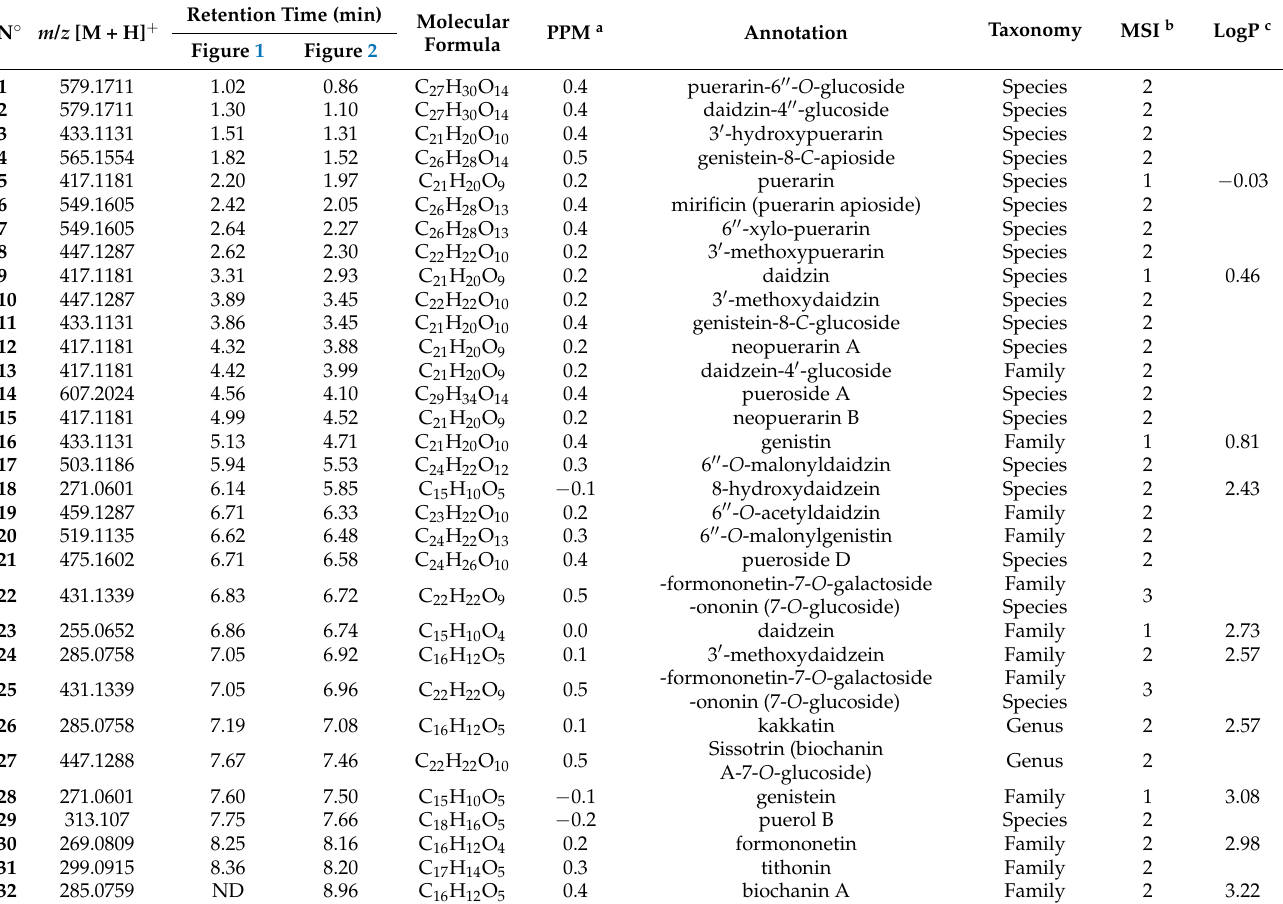
Table 1. Annotation of PLRE constituents and its intestinal